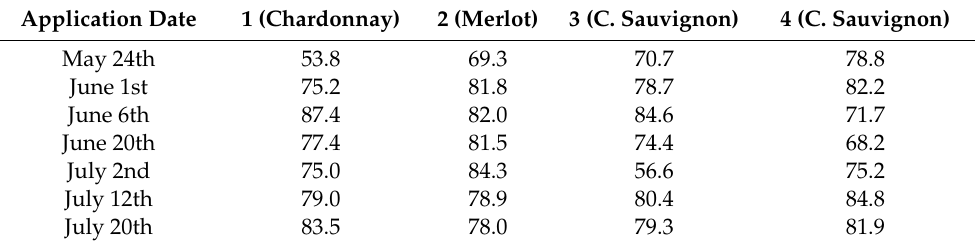
Figure 8. Example of accuracy distribution classified according to 0, 5, 10 and 20% threshold. Table 5. Percentage of points classified as successful points, assuming a ± 10%